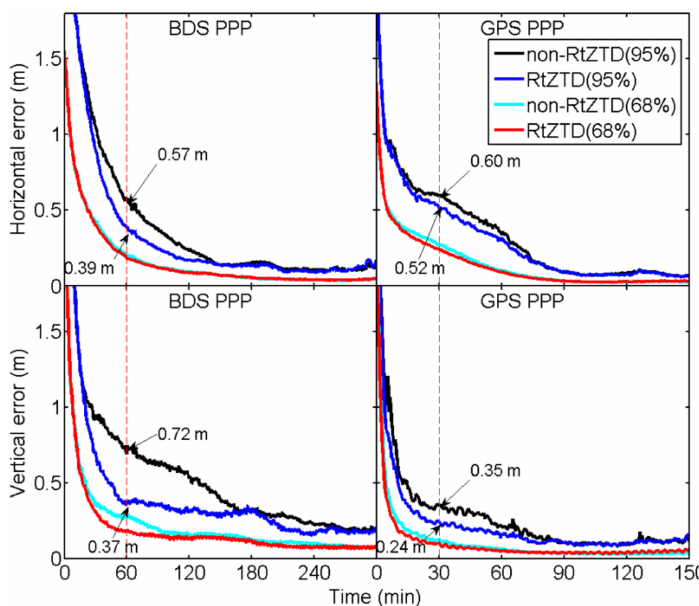
Figure 8. Convergence time comparison for BDS/GPS PPP in horizontal component and vertical component.